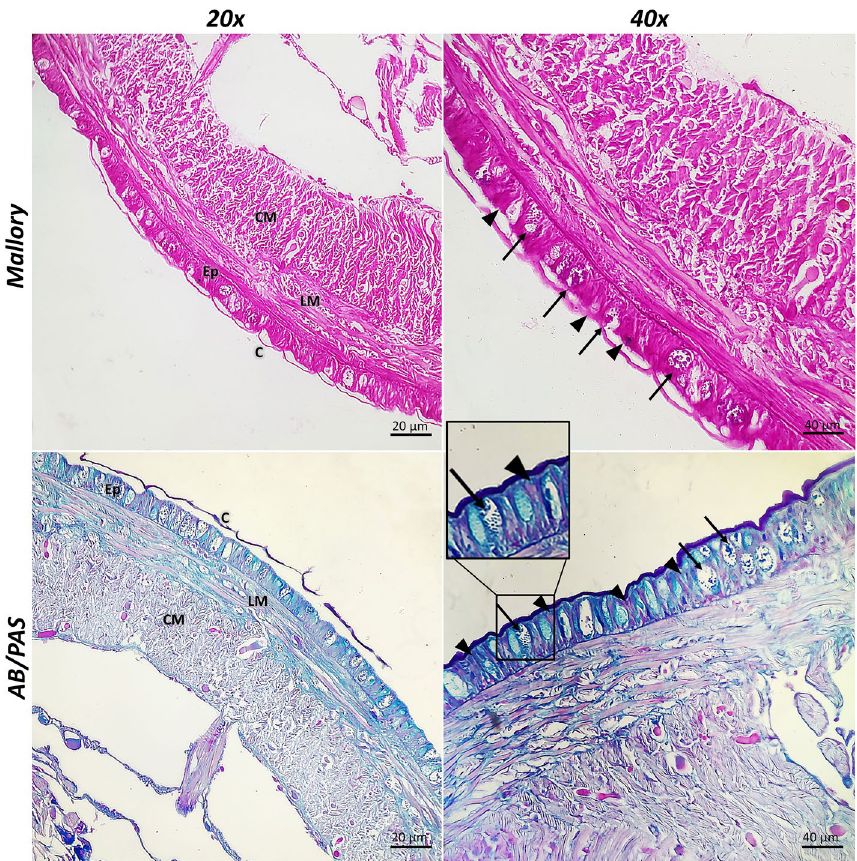
Fig. 1 Cross Sects. (5 µm thick) of Lumbricus terrestris , 20x and 40x. These sections were stained with Mallory Trichrome and AB/PAS demonstrating the architecture of the cuticle (C), the epidermis (Ep), longitudinal muscle (LM), and circular muscle (CM). The epidermis is morphologically well-defined; it is either a single epithelial layer or pseudostratified; it consists of supporting epithelial cells (arrowheads) and mucous glandular cells (arrows)